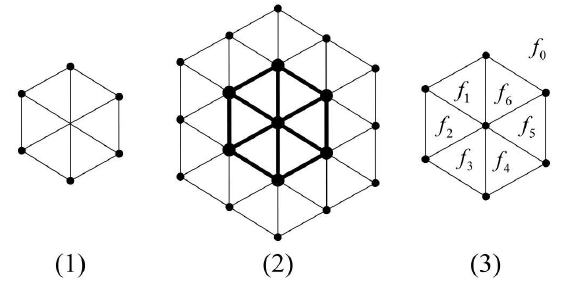
Figure 1. Hexagonal meshes: (1) HX(2) , (2) HX(3), and (3), all facing HX(2).